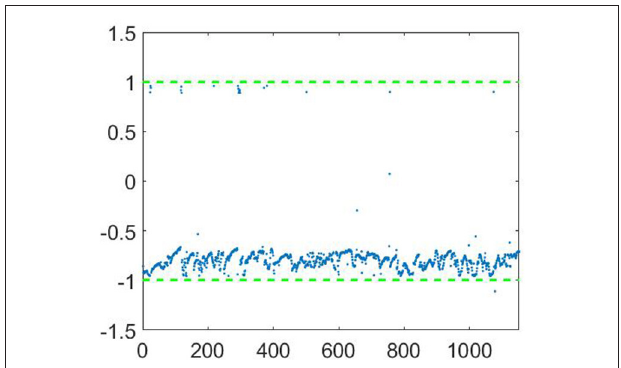
FIGURE 12 | The example of decisions for frames of an audio recording of a female speaker.